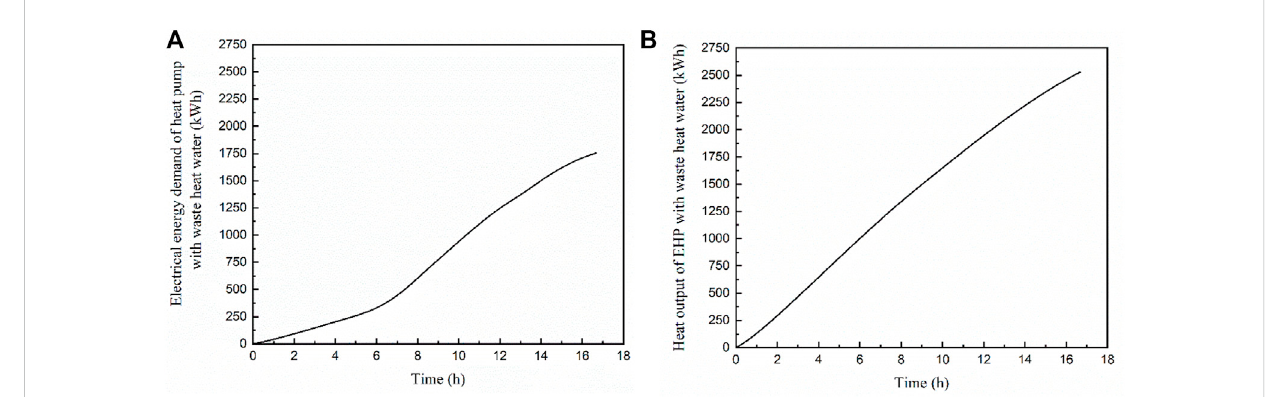
FIGURE 14 Simulation results of a triple cogeneration system (heating process with waste heat water) with (A) electrical energy demand of an EHP change and (B) heat output of an EHP